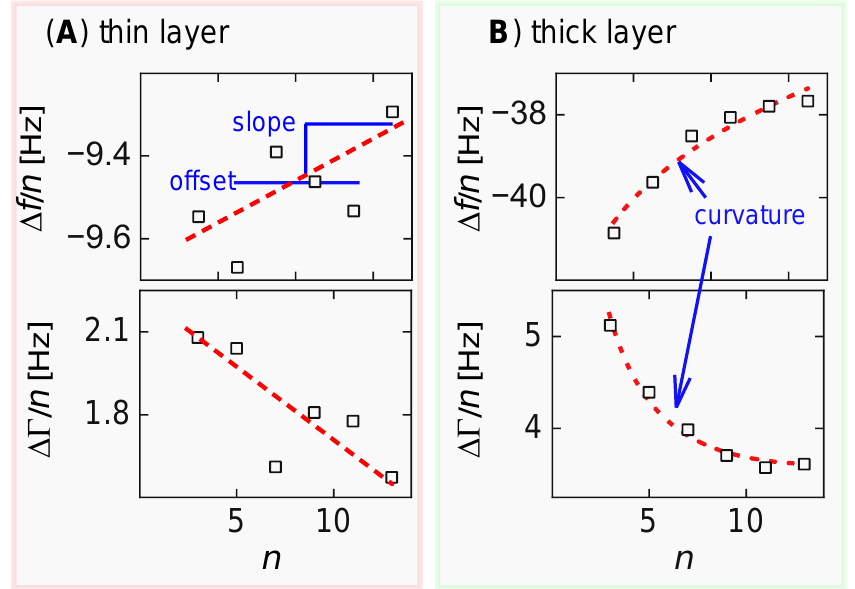
Figure 2. For very thin films ( A ) the fractional noise is too large to let a curvature in plots of ∆ f / n and ∆Γ / n versus n be determined reliably. Interpretation must rely on the offsets and the slopes for ∆ f / n and ∆Γ / n (totaling four parameters). If the model contains five parameters the problem is underdetermined. For thicker films ( B ) the curvatures can be determined reliably; thus, five model parameters can also be derived reliably.